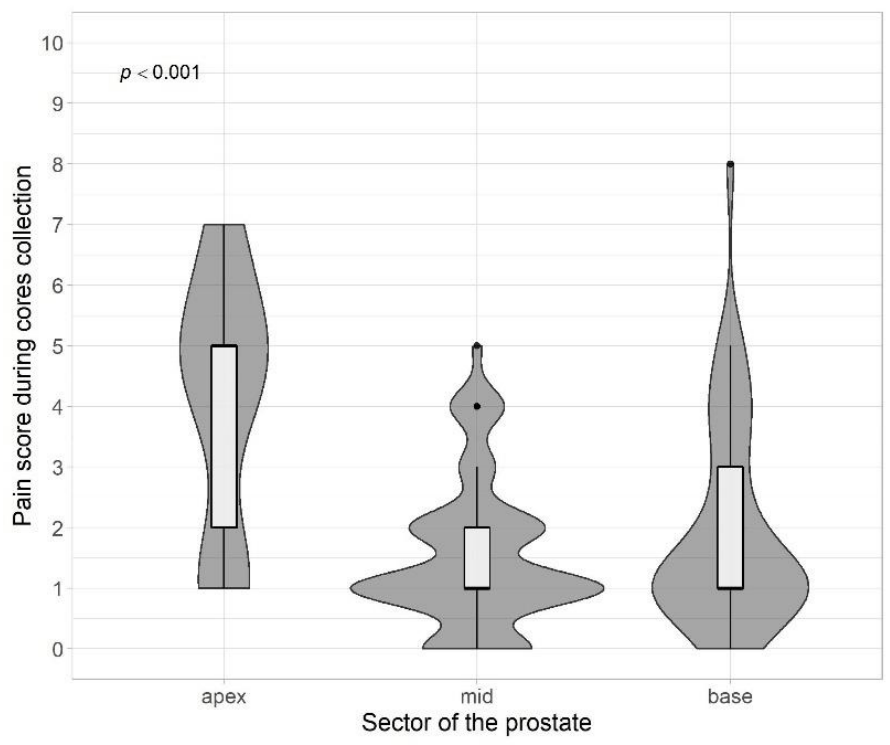
Figure 2. Pain score vs. target localization level. Table 2. The assessment of the relationship between perceived pain and clinical data.